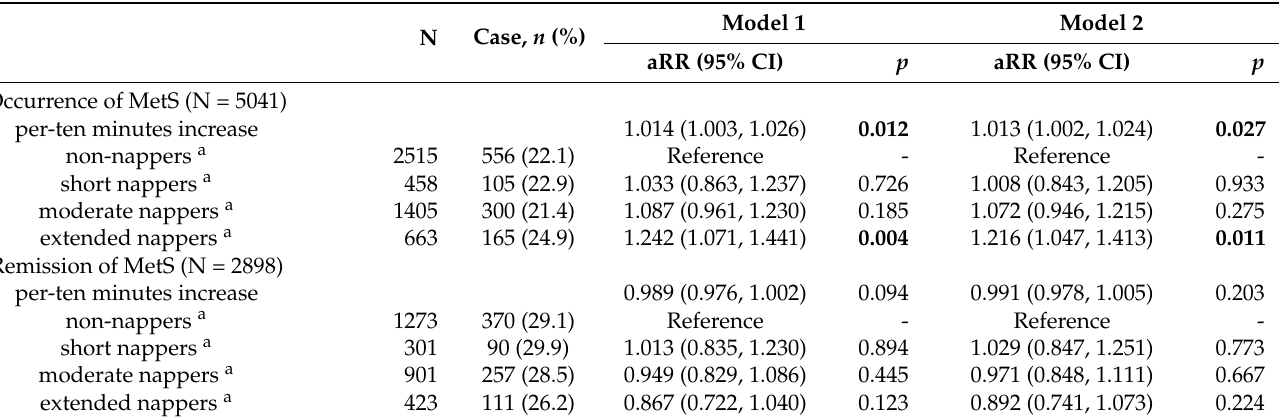
Table 2. Longitudinal associations of baseline daytime napping duration with the occurrence and remission of MetS. N Case, n